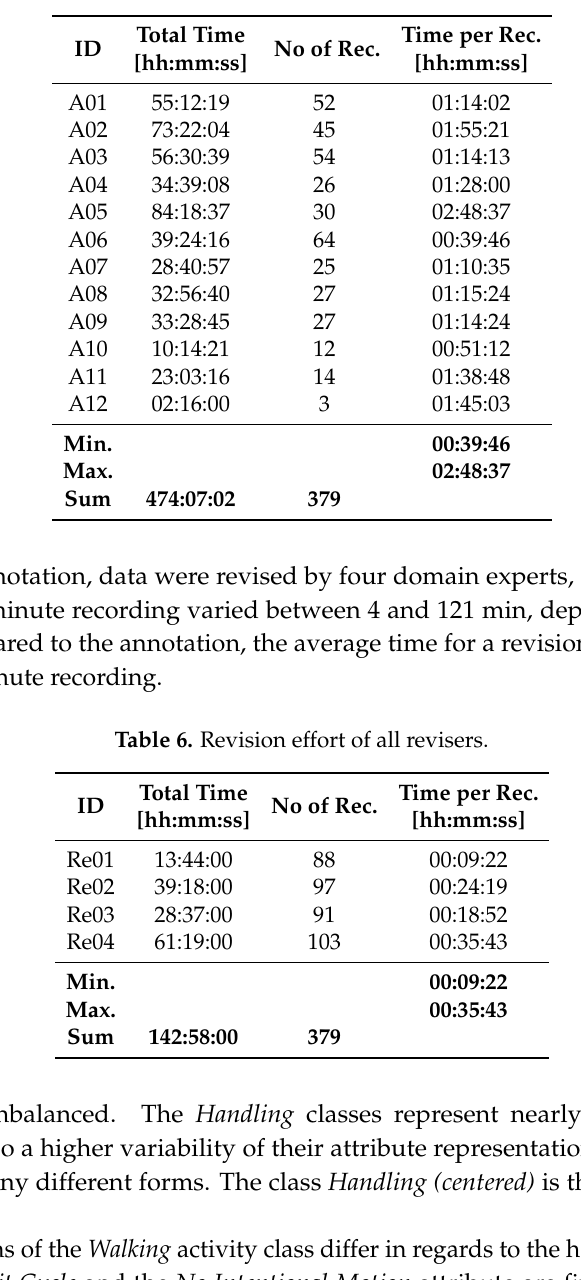
Table 5. Annotation effort of all annotators.